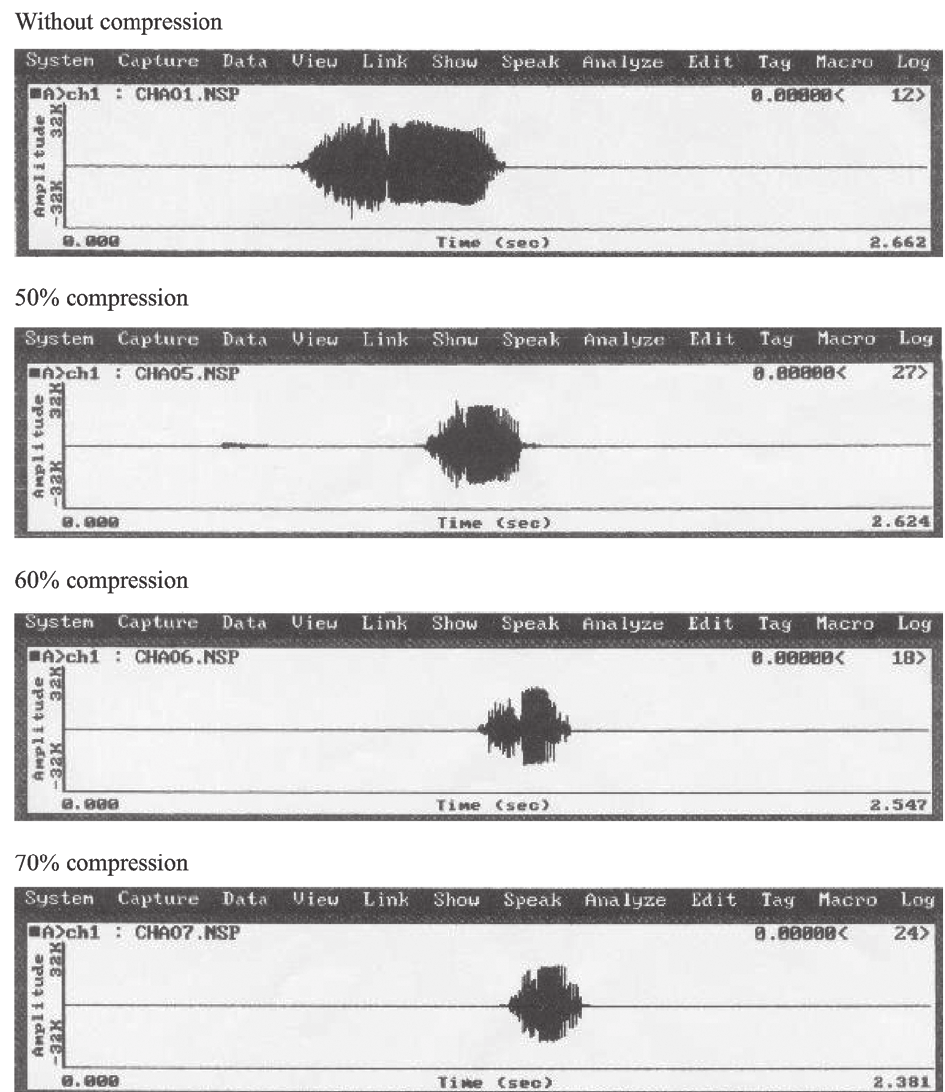
Figure 1 - Spectogram of the monosyllable “ chão ” (without compression; with 50%; 60% and 70%